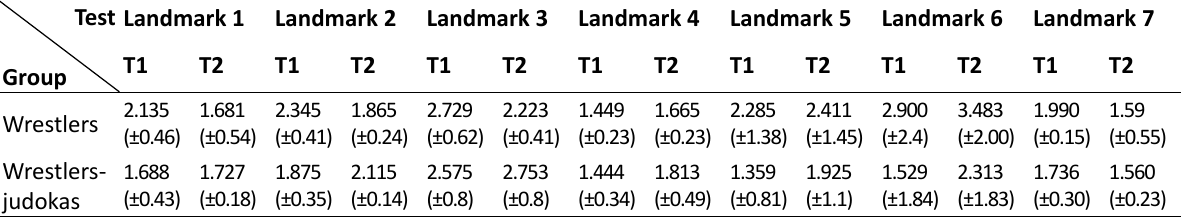
Table 1. Peaks of speeds (m/s) on the level of the various landmarks for the wrestlers and the wre-judokas during the first and the second test. Average values and standard